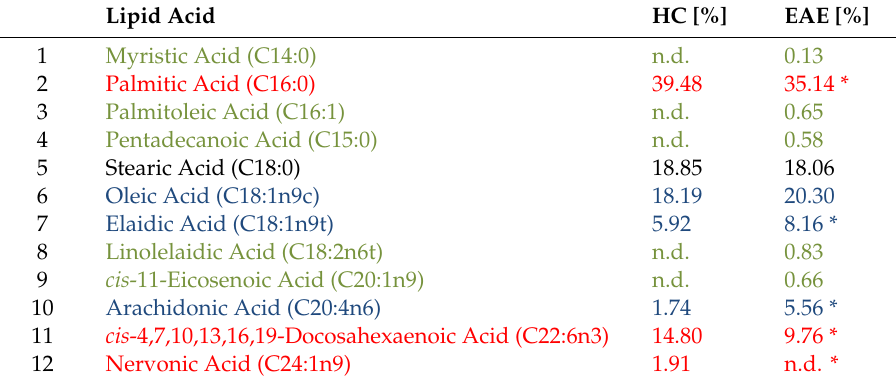
Table 1. The lipid composition of experimental autoimmune encephalomyelitis EAE and healthy control (HC) brains. Red color indicates the lipids that are reduced in the course of disease. A blue color indicates the lipids that are relatively upregulated during EAE, while a green color indicates the new appearing lipids involved in arachidonic acid (AA) metabolism. Data are presented as the percentage of lipids from three independent experiments (one mouse per one